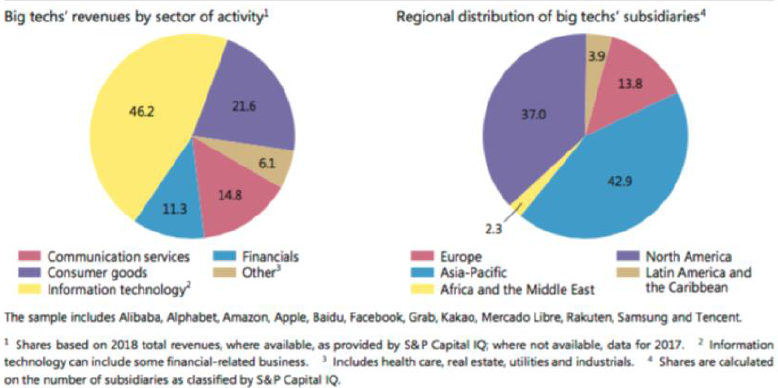
Figure 1: BigTechs revenues by sector of activity and regional distribution of BigTechs’ subsidiaries; Source : Bank for International Settlements, 2019: 56